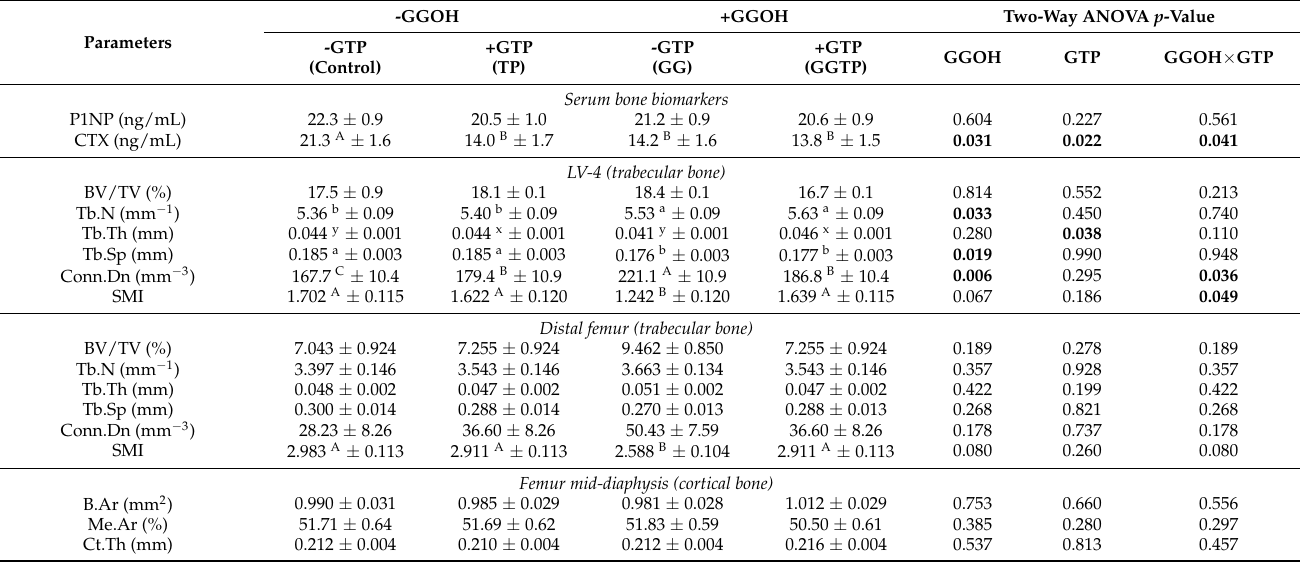
Table 2. Effects of GGOH and GTP supplementation on bone parameters.